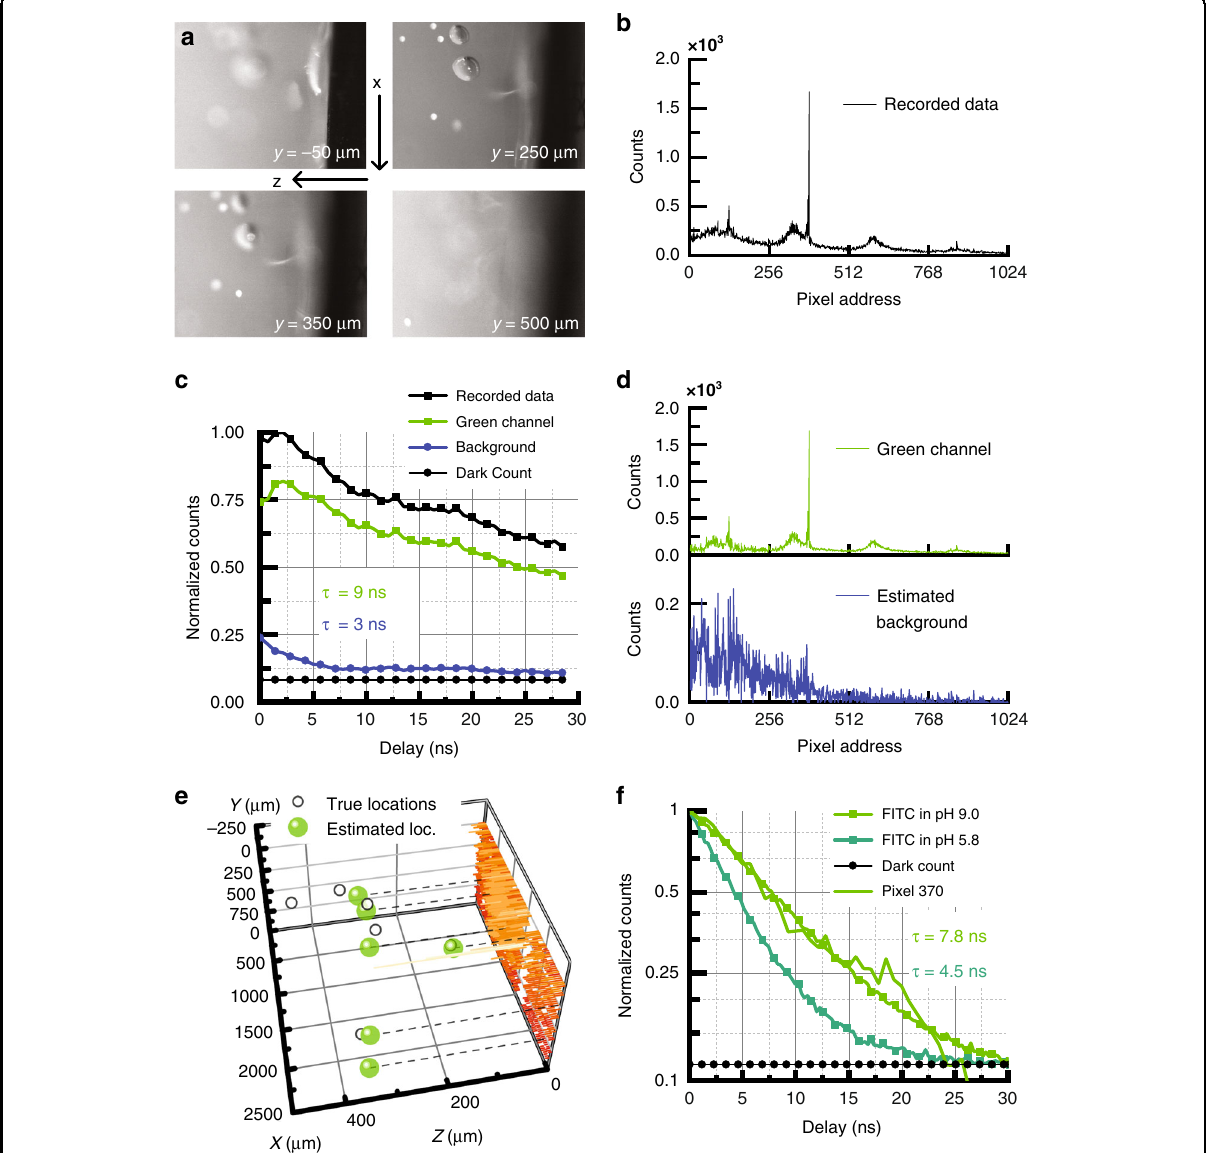
Fig. 5 Localization in scattering medium. a Photomicrograph of 45 µm polymer beads containing Fluoresbrite YG, dispersed in 1.5% agar simulating scattering tissue. The probe is inserted at z = 0 orthogonal to the direction of excitation light. b Recorded data from MIMAS imager chip at 0 ns delay. c Time series for mean recorded data, estimated fl uorescent signal and excitation background through blind source separation. d Estimated scattered illumination background and fl uorescent data after blind source separation. e Volumetric localization through an L = 6 sparse representation, compared with fl uorescent bead ground truth. f Lifetime calibration for FITC as a function of environment pH. The lifetime fi ngerprint of pixel 370 reveals the Fluoresbrite is encapsulated in an environment of pH =